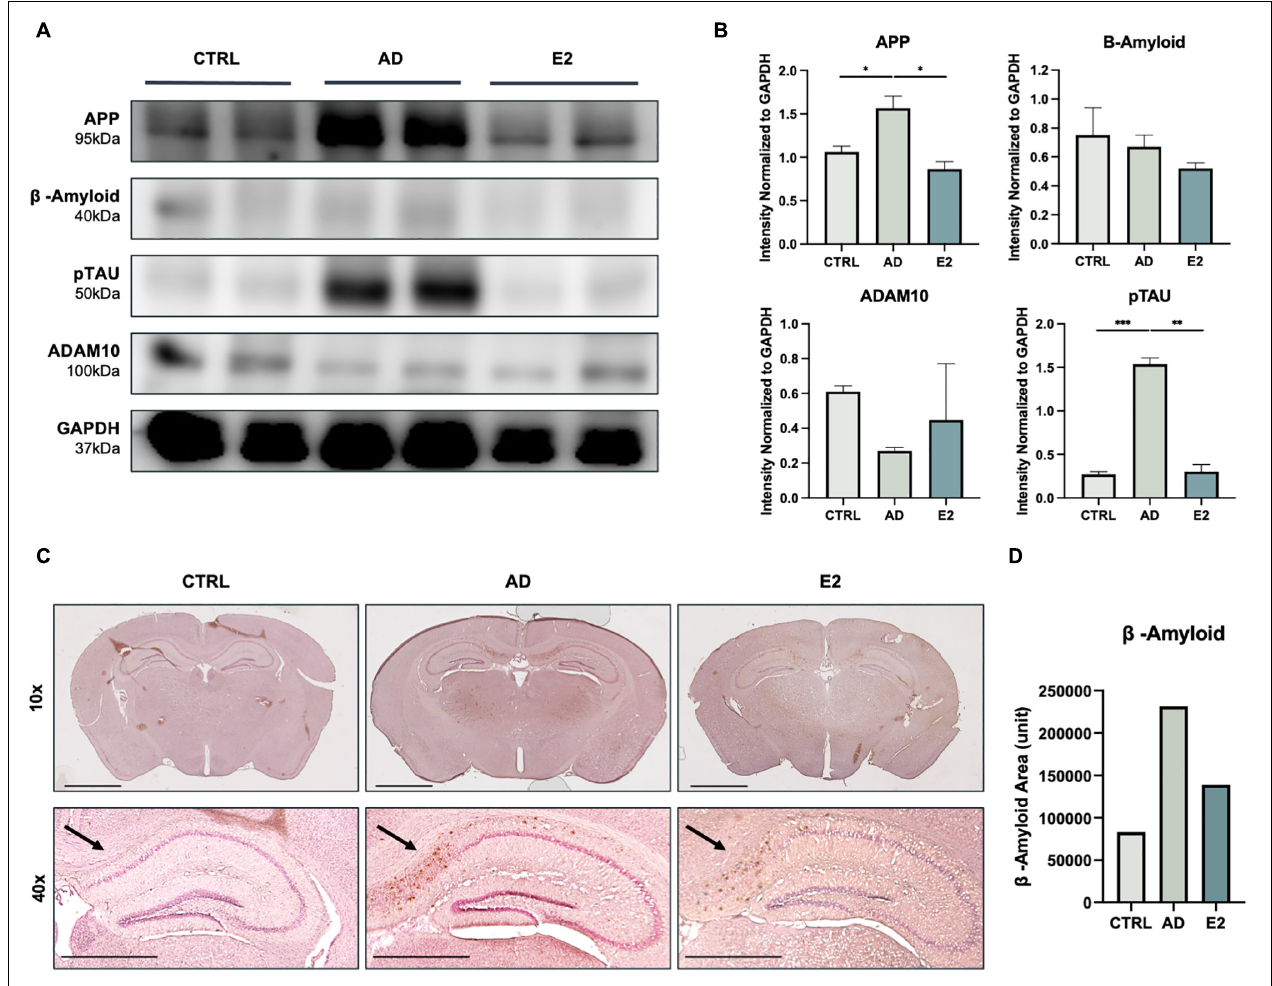
FIGURE 2 | Histological analyses of brain tissues from control, 5xFAD, and ovariectomized 5xFAD model mice treated with estrogen. (A) Western blotting for the measurement of amyloid precursor protein (APP), amyloid-beta (A β ) protein, phosphorylated tau (TAU) protein, and ADAM10 protein levels in each group. (B) Quantification in western blotting assay with protein levels normalized to that of GAPDH. (C) Immunohistochemical assay showed A β plaque accumulation in mouse brains, with significant clustering in the cortical and hippocampal regions. Scale bar, 2000 µ m for 10x, 1000 µ m for 40x. (D) Quantification of A β -positive areas, measured using ImageJ. t -tests were used for data analysis ( ∗ P < 0.05, ∗∗ P < 0.01, ∗∗∗ P <